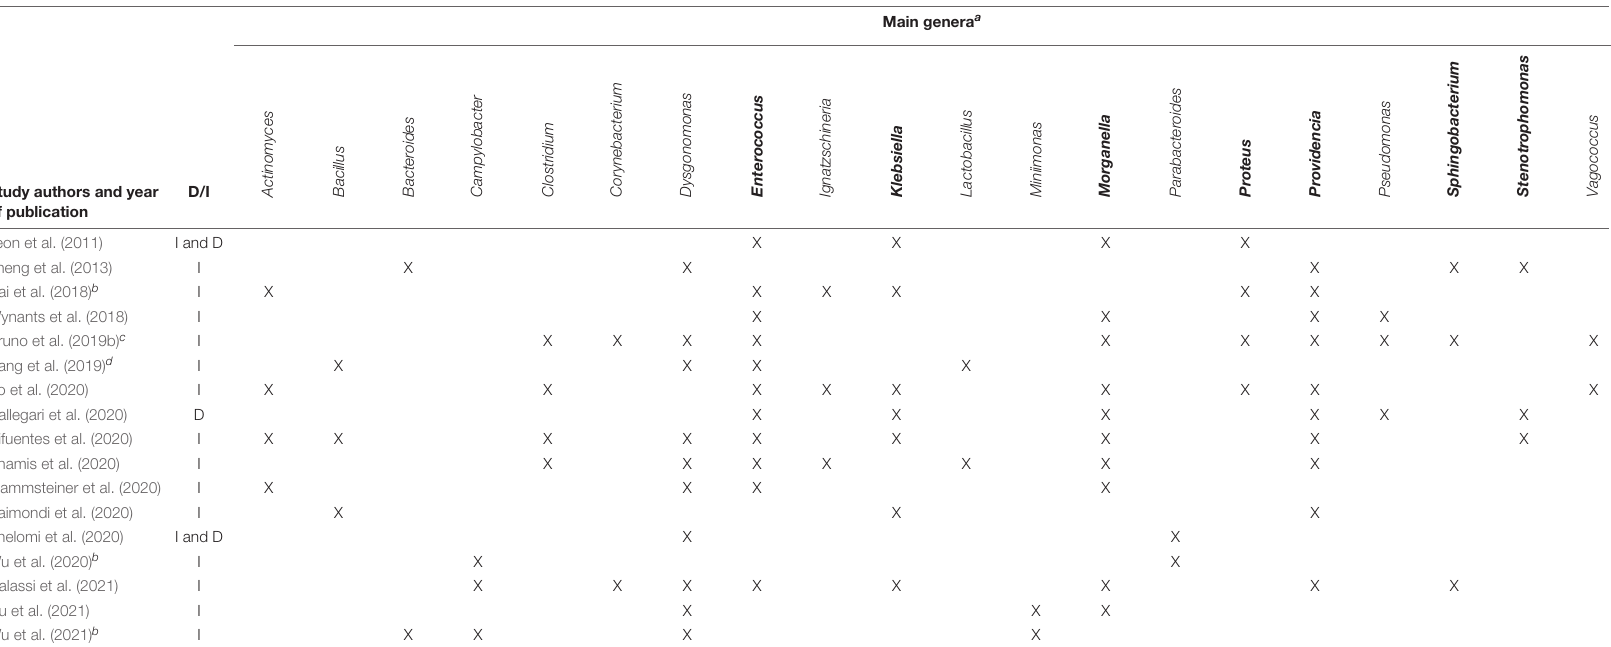
TABLE 1 | Summary of literature data (from 2011 onward) involving an assessment of the composition of the microbiota of BSFL, either in a culture-dependent (D) or in a culture-independent (I)